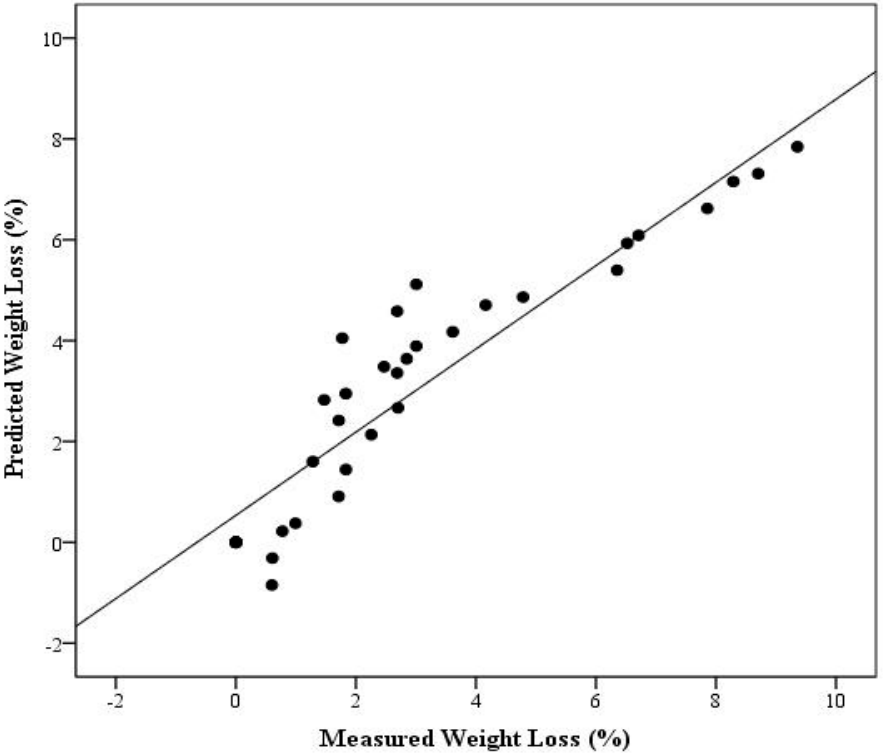
Figure 5. Results for the prediction of weight loss (WL) values based on linear regression models.